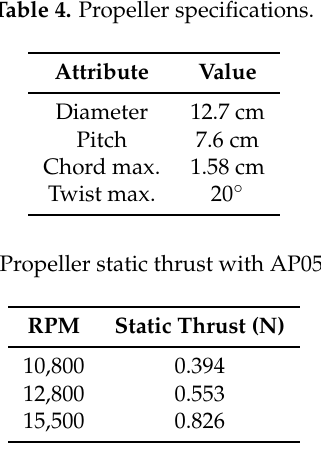
Table 4. Propeller specifications.